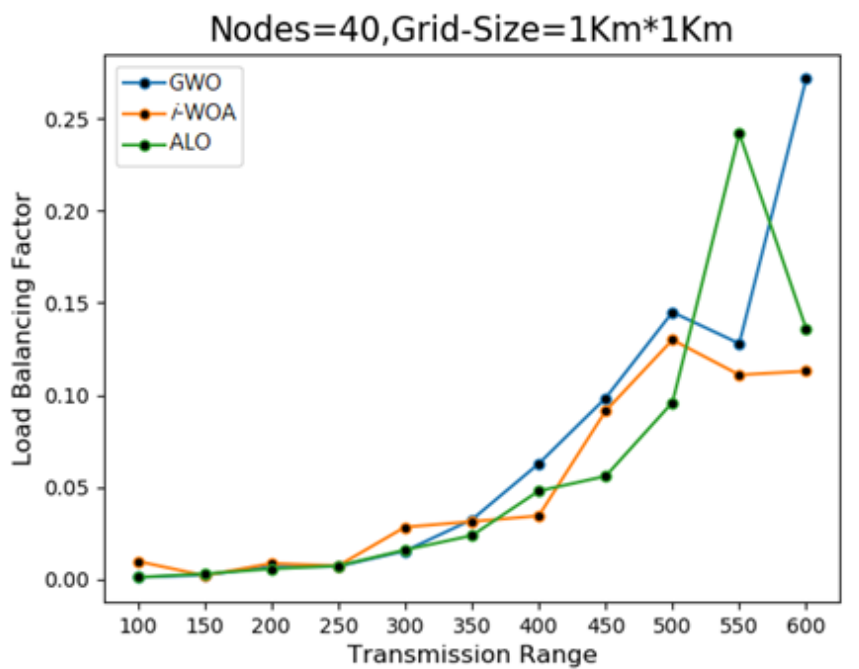
Figure 10. Load balance factor for 40 Nodes at the Grid size of 1 km × 1 km.